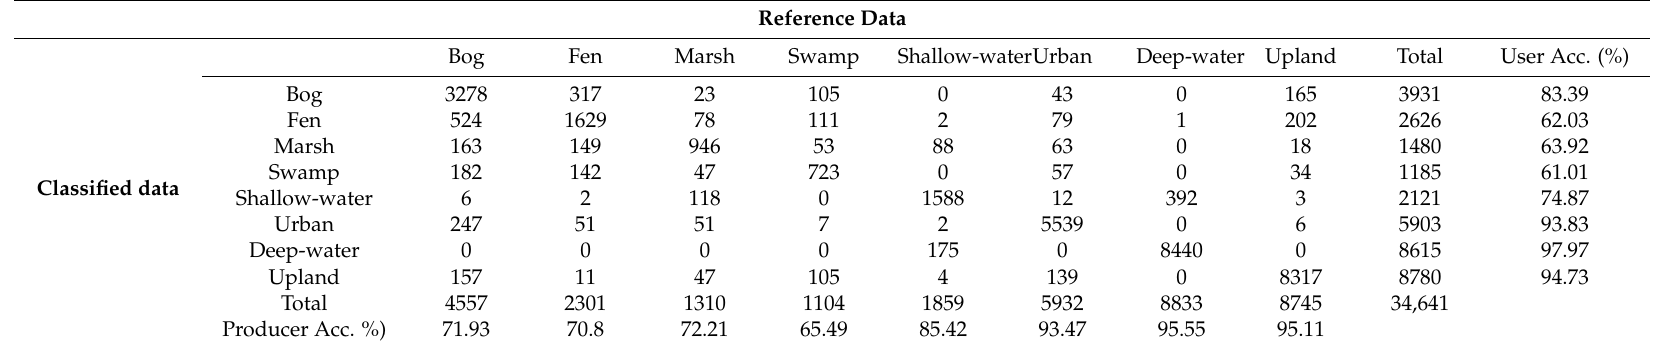
Table 6. The confusion matrix of the Avalon classification map obtained from the CP SAR data. An overall accuracy of 87.89% and Kappa coefficient of 0.85 were